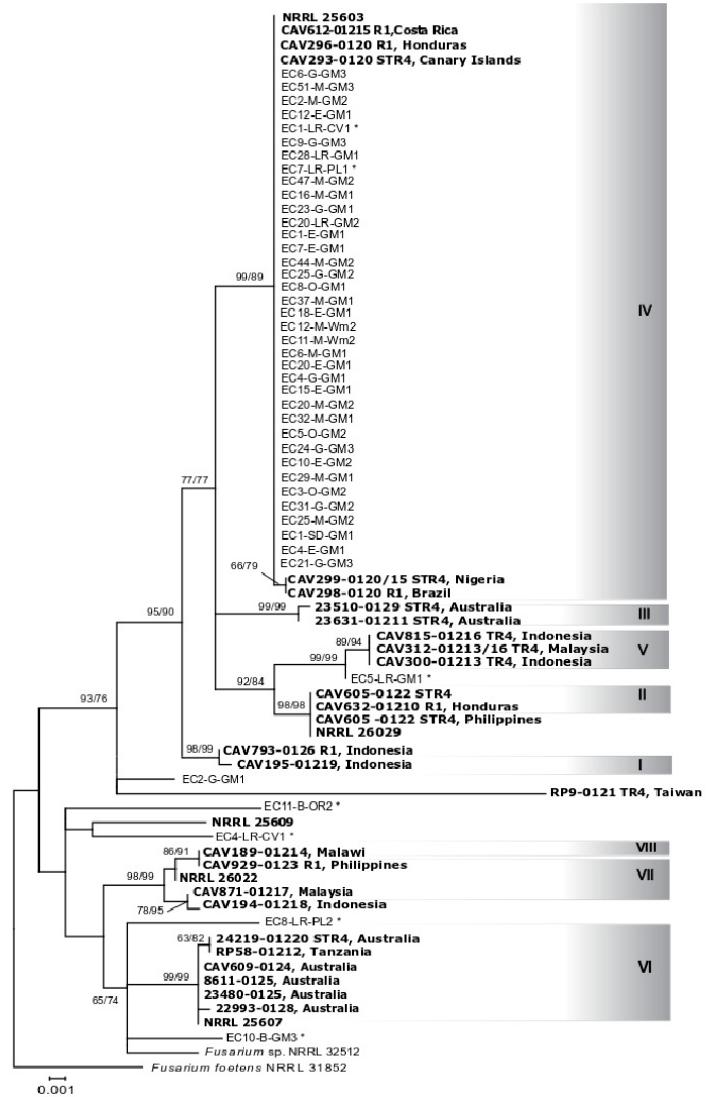
Figure 4. Maximum likelihood phylogenetic tree containing 44 selected F. oxysporum isolates associated to banana from Ecuador inferred from intergenic spacer region (IGS) sequence data. Clonal lineages previously identified in translation elongation factor 1 alpha (TEF)-maximum likelihood (ML) tree are shadowed and reference strains marked in bold. F. oxysporum isolates from asymptomatic banana are marked with an *. Numbers above internodes represent the ML and maximum parsimony (MP) bootstrap support. The tree is rooted with Fusarium sp. NRRL 32512 and Fusarium foetens NRRL 31852.